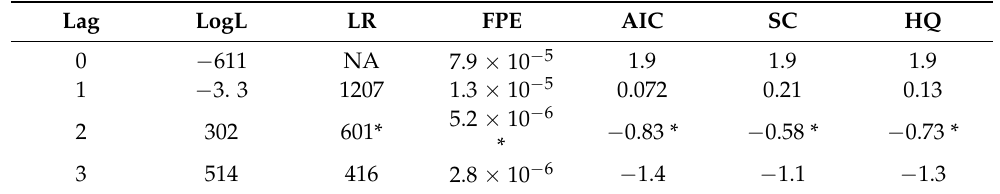
Table 5. Results of the lag length test for the VAR model constructed by four groups of hydro- meteorological